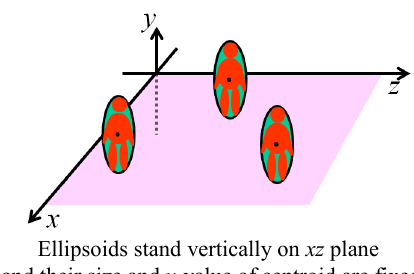
Figure 4. Ellipsoid settings of human position and shape